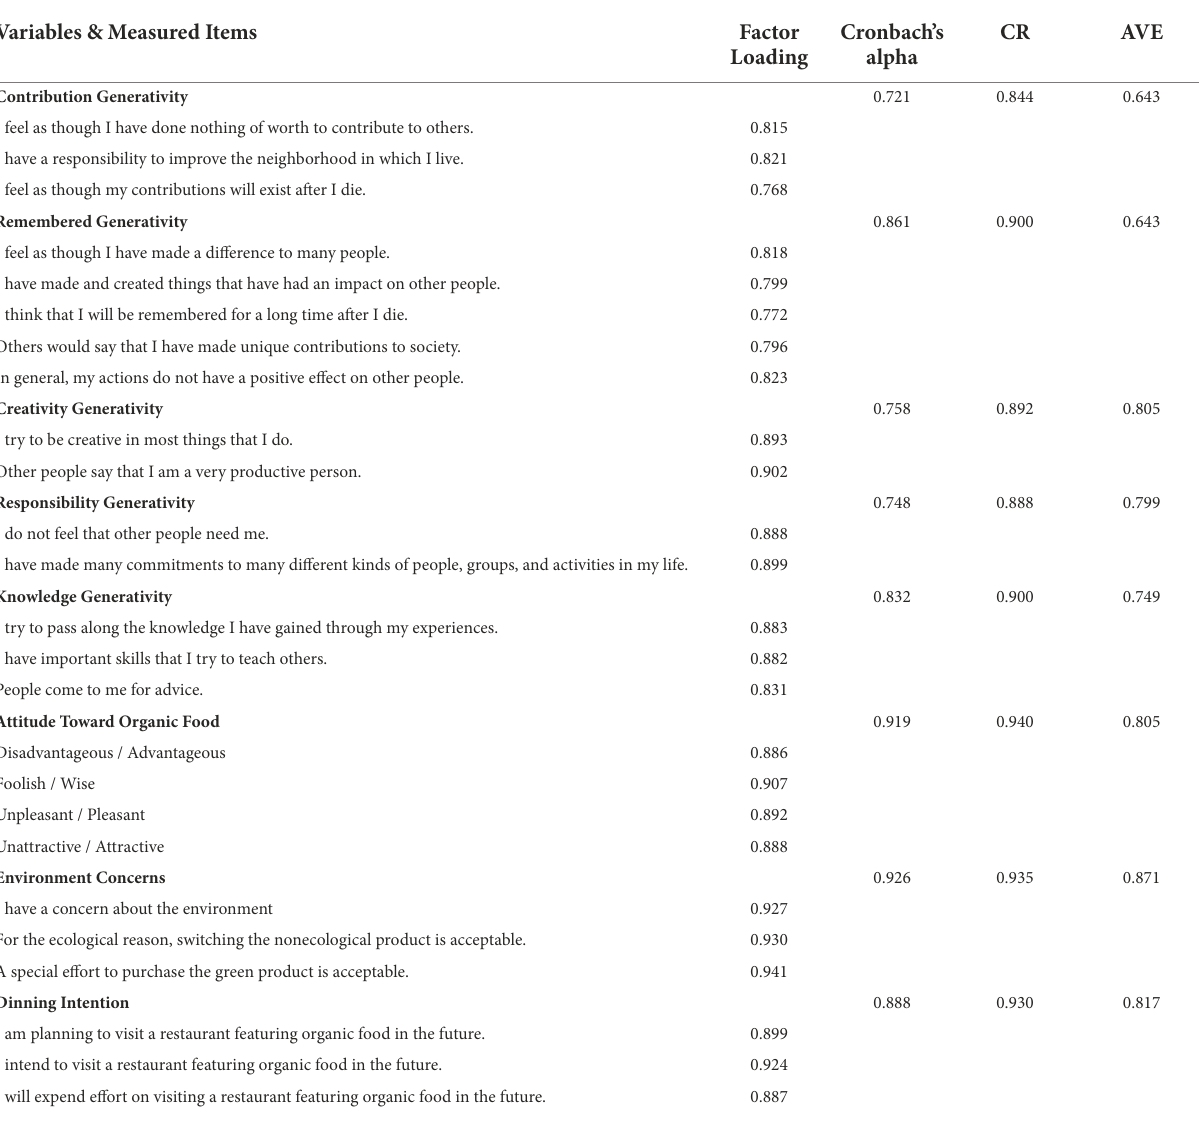
TABLE 3 Item, reliability, and convergence